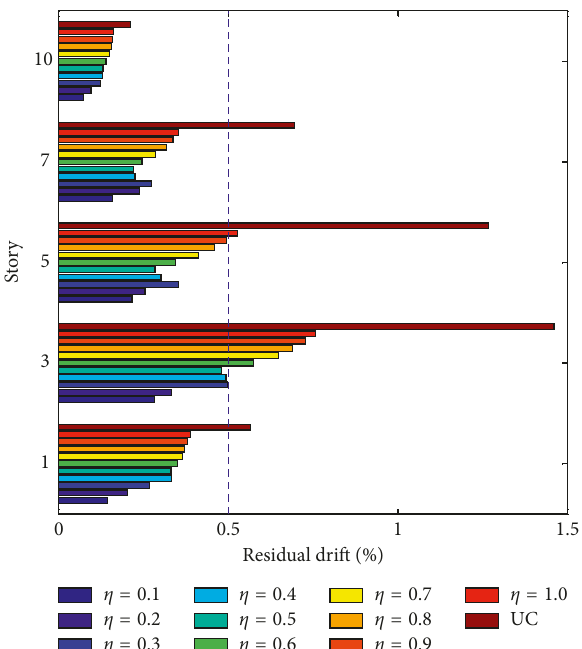
Figure 24: Analysis results of structural residual interstory